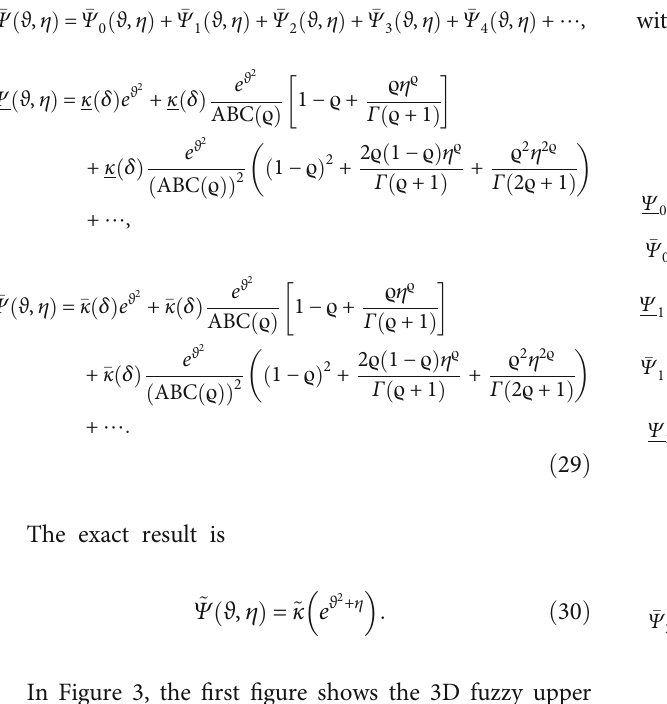
In Figure 3, the fi rst fi gure shows the 3D fuzzy upper and lower branches of analytical solution at ρ = 1 and the 2nd fi gure shows the 2D fuzzy fi gure at ϱ = 1 . In Figure 4 are the various fractional order ρ fi gures of upper and lower branches of analytical solution.